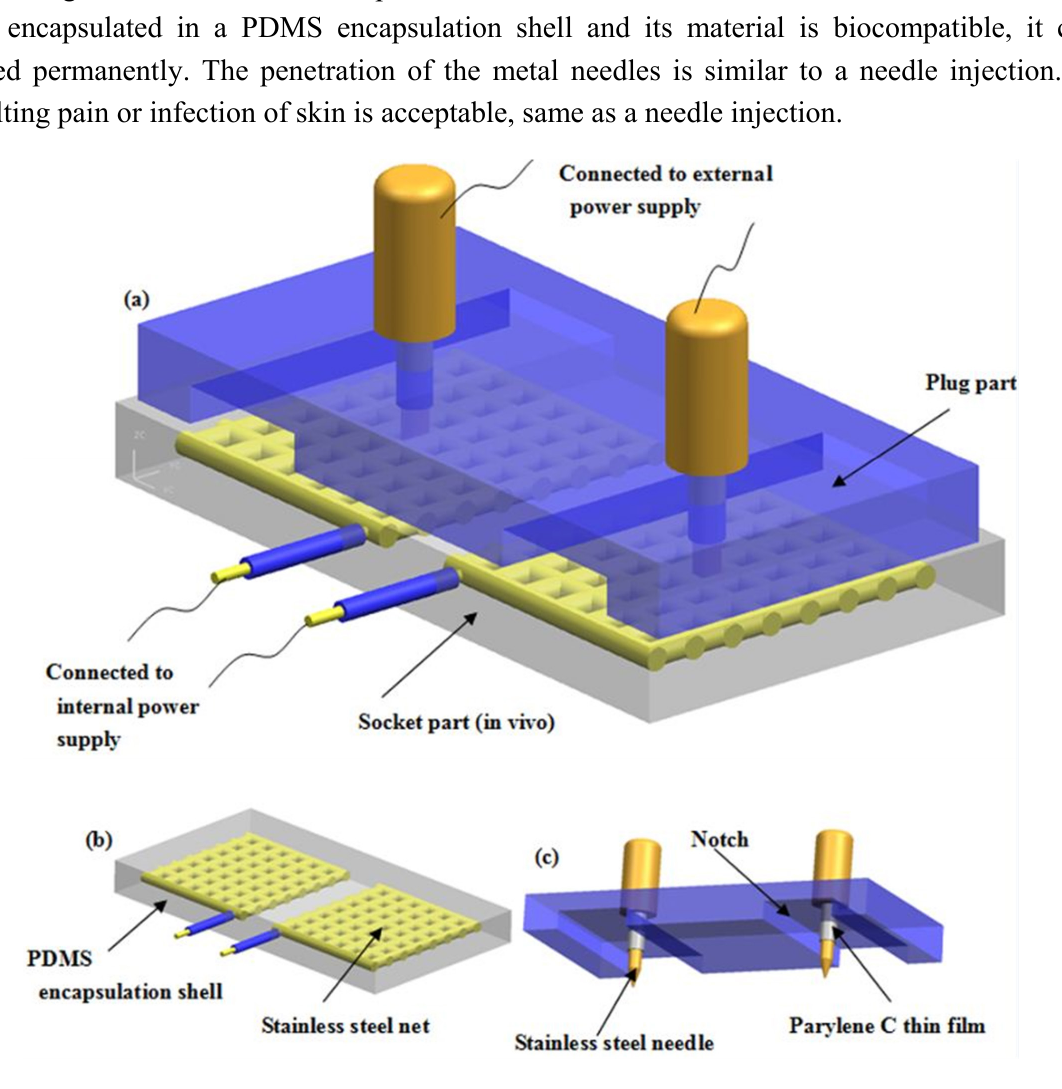
Figure 2. Conceptual diagram of the typical implantable microsystem. The schematic of the transdermal power transfer device. ( a ) The schematic of transdermal power transfer